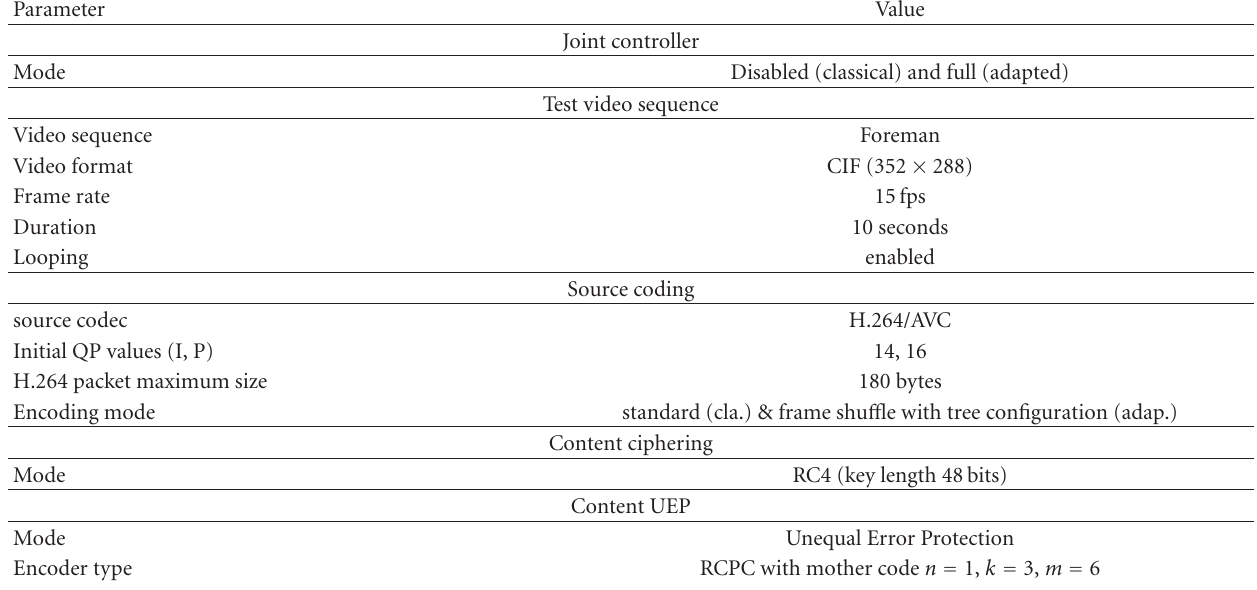
Table 2: Recapitulation of the considered simulation